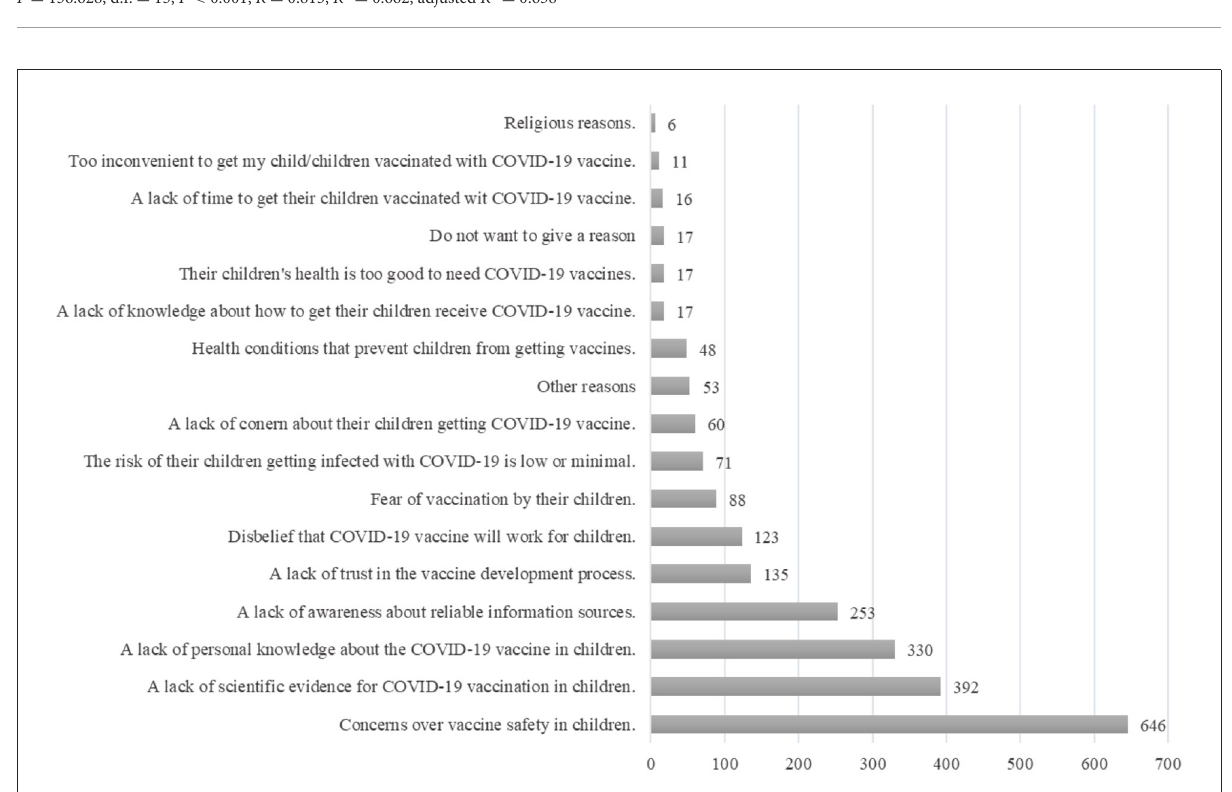
FIGURE2 Reasons for not intending to get their children receive COVID-19 vaccines.